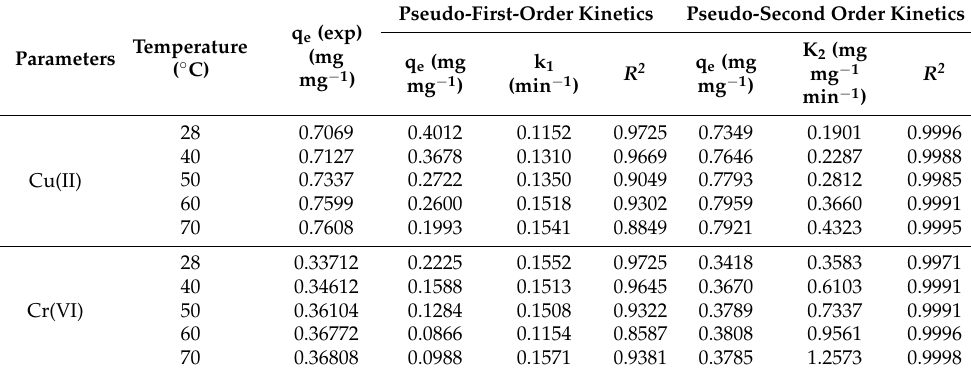
Table 2. Kinetics parameters for the removal of Cu(II) and Cr(VI) from aqueous solution using M-OPEFB-CNF as a